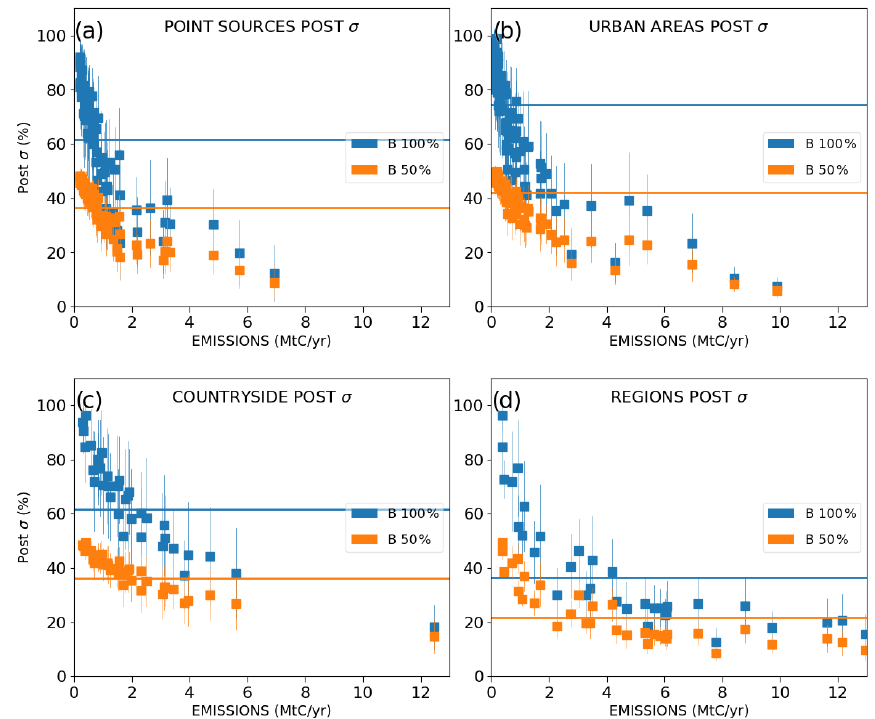
Figure A1. Same as Fig. 7 but the relative posterior uncertainties are shown instead of the UR.